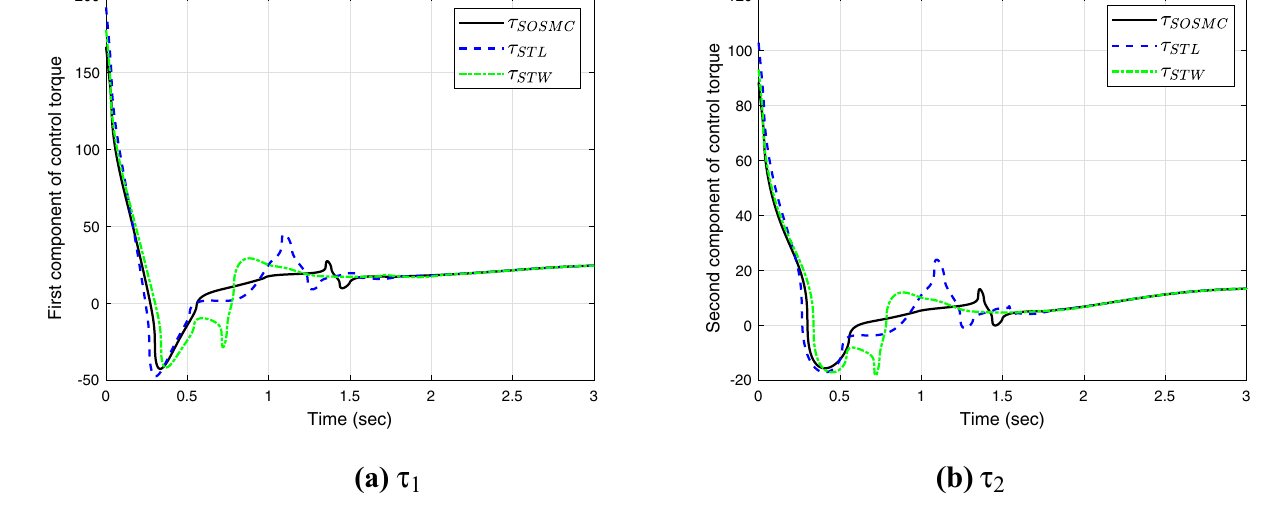
Fig. 10 Comparison of external torques 𝜏 1 and 𝜏 2 for SOSMC, STW and STL